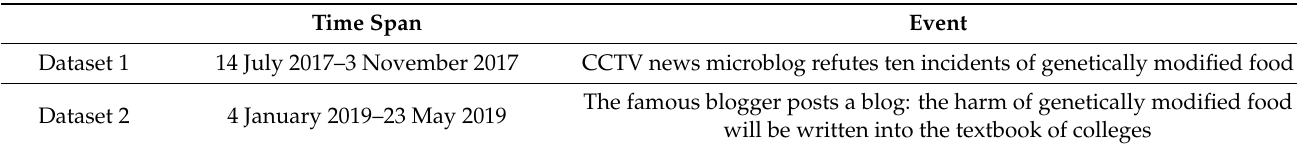
Table 2. The details of event datasets.